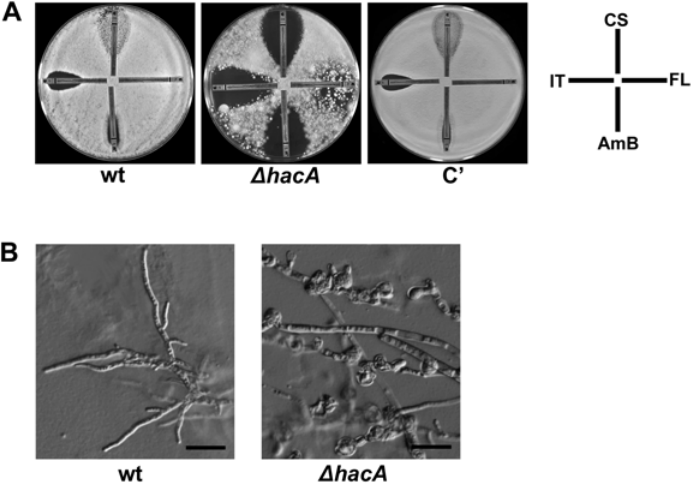
Figure 8. The D hacA mutant is hypersensitive to antifungal drugs. (A) Antifungal susceptibility using Etest: conidia were spread evenly onto a 150 mm plate of RPMI agar. Four Etest strips, each impregnated with a concentration gradient of caspofungin (CS), fluconazole (FL), amphotericin B (AmB), and itraconazole (IT) were applied to the surface, with the highest concentration oriented at the plate edge. (B) Microscopic analysis of caspofungin-treated hyphae. Equal numbers of conidia from the indicated strains were spread onto the surface of an IMA plate and allowed to germinate at 30 u C for 24 h. A caspofungin Etest strip was then applied to each plate and incubated overnight at 37 u C. The morphology of the hyphae surrounding the highest concentration on the strip was observed by DIC microscopy. Scale bar represents 50 m